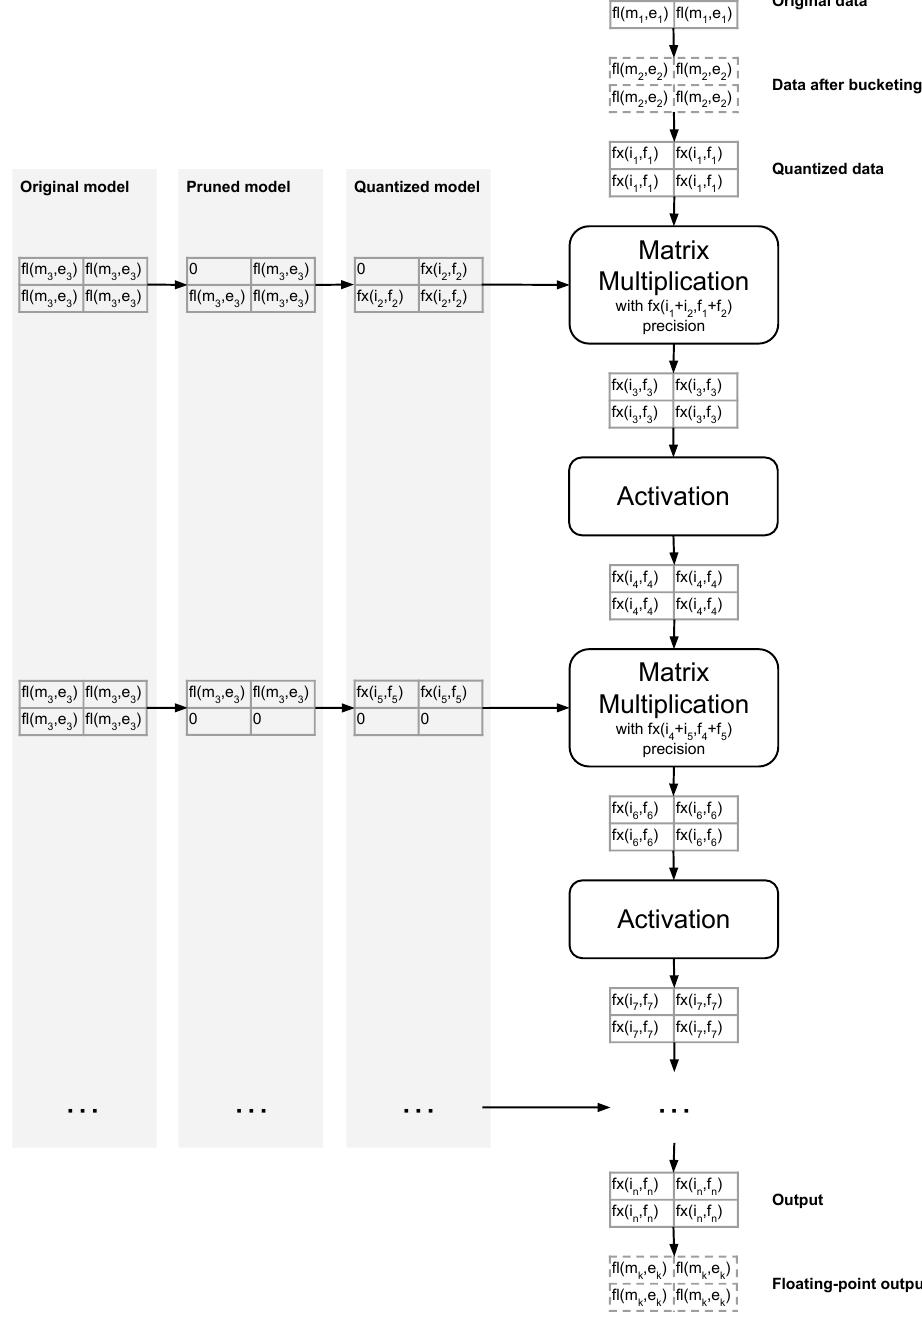
Figure 3. Simplified data flow during inference; fl ( m , e ) denotes a number in floating-point notation, with m bits for mantissa and e bits for exponent; fx ( i , f ) denotes a number in fixed-point notation, with i bits for integral part and f bits for fractional. In the simplest case m 0 = m 1 = . . . = m k , e 0 = e 1 = . . . = e k , i 0 = i 1 = . . . = i n and f 0 = f 1 = . . . = f n , however those values can be arbitrary chosen to achieve the best resources